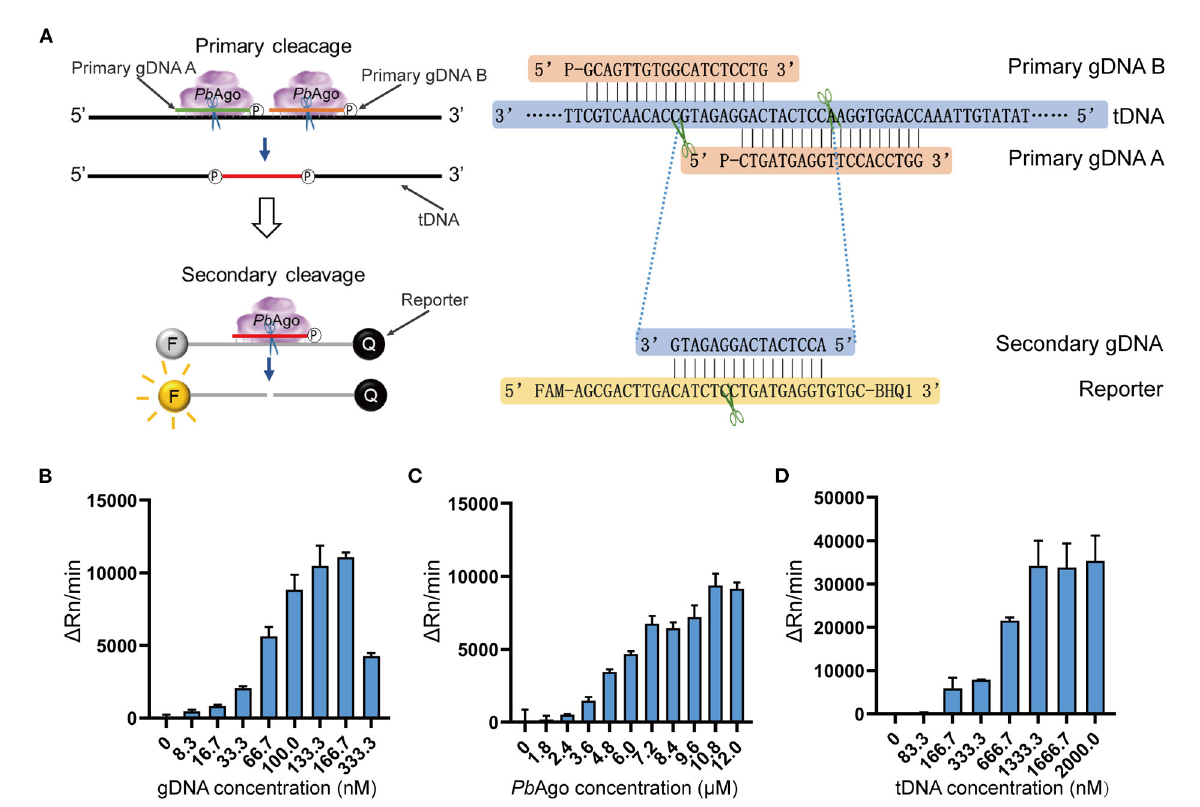
FIGURE3 Optimization of an isothermal detection reaction of mesophilic Agos. (A) Schematic and sequence diagram of stepwise clevage in the isothermal detection system. (B–D) Fluorescence values of Pb Ago stepwise cleavage under different concentrations of gDNA (B) , Pb Ago (C) , and tDNA (D)